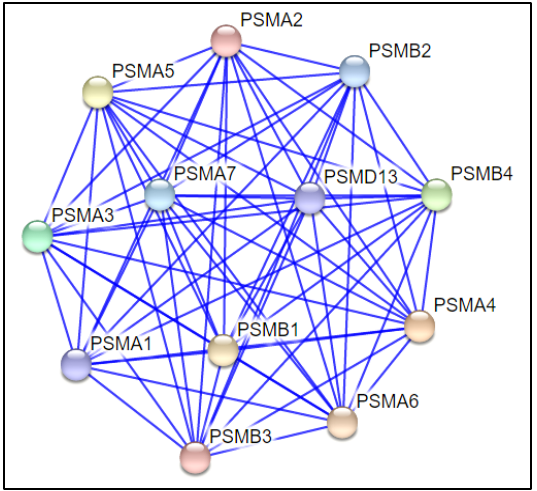
Figure 6. STRING analysis showing the interaction among the proteins involved in the proteasome complex.